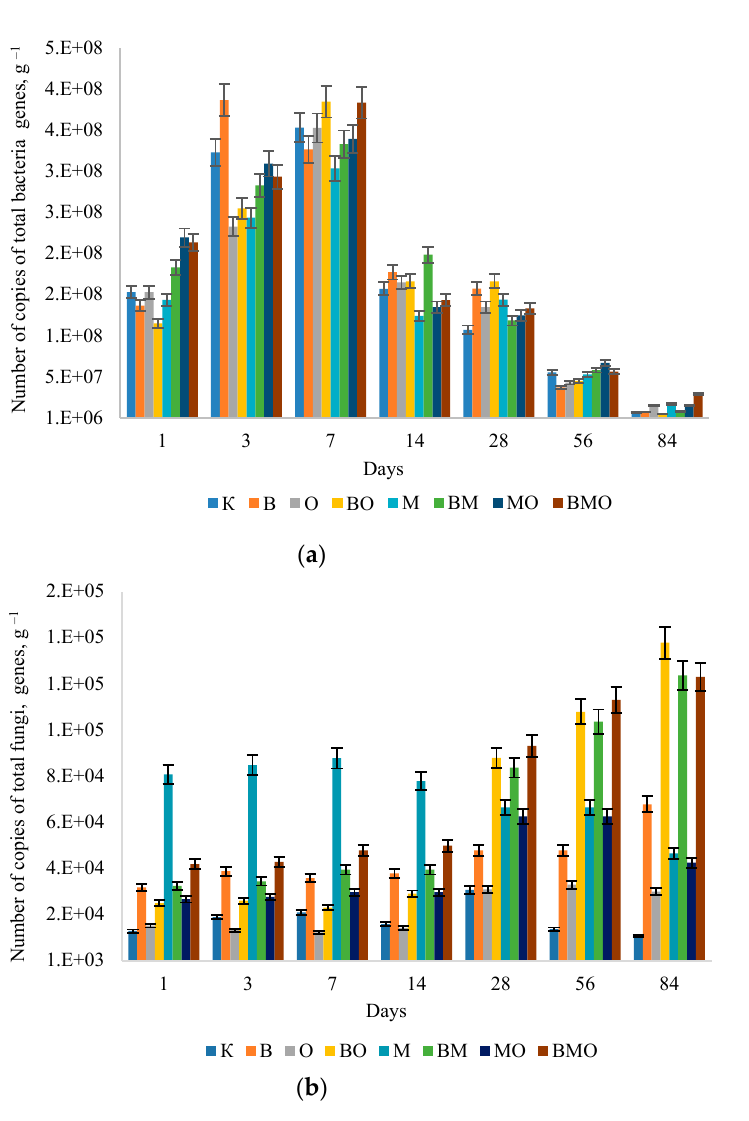
Figure 2. Bacterial ( a ) and fungal ( b ) gene copy numbers in the compost mixtures.